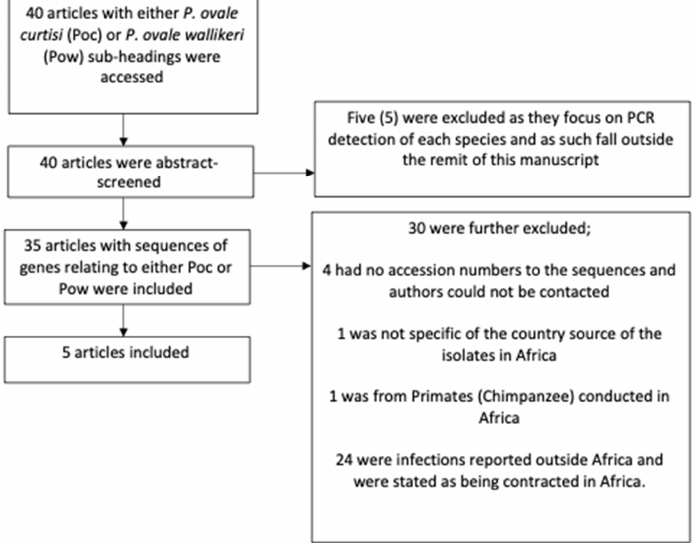
(Figure 1). A summary of the number of sequences retrieved from the different countries and selected target genes is provided (Table 1).